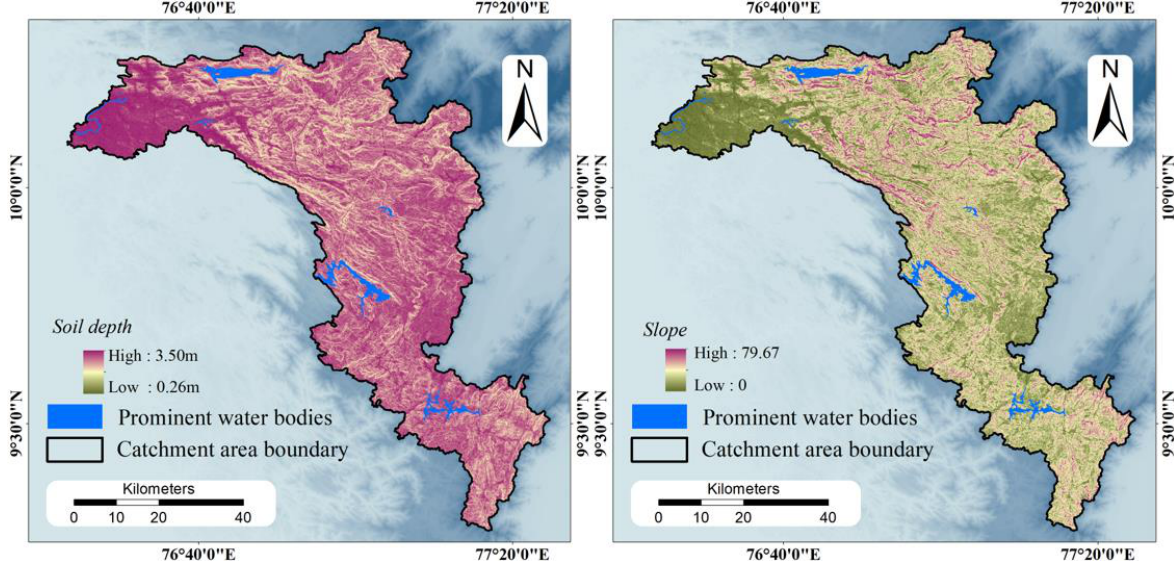
Figure 6. Spatial distribution of soil thickness and slope in the study area.